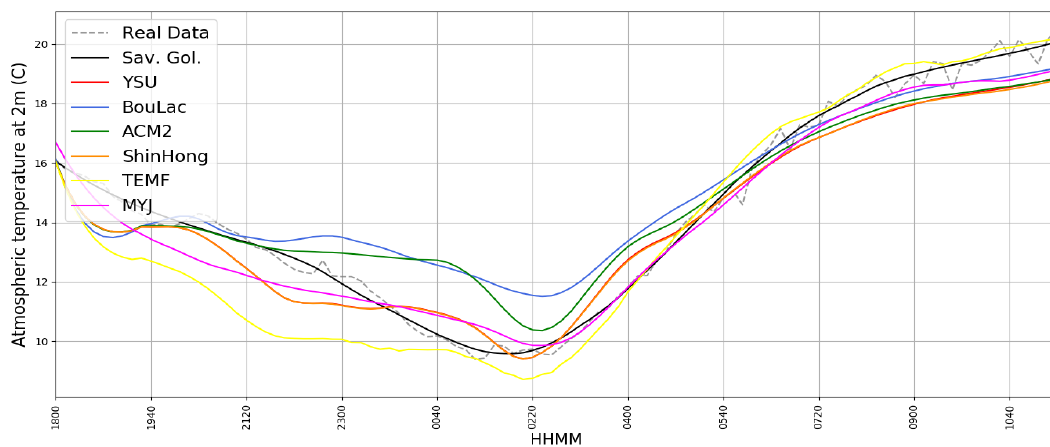
Figure 10 . Simulated T2M timeseries compared with real GL T2M timeseries, 17/05/2017, dotted grey: real data, black: Savitsky – Golay smoothing of real data, red: simulated data with YSU parametrization, blue: simulated data with BouLac parametrization, green: simulated data with ACM2 parametrization, orange: simulated data with ShinHong parametrization, yellow: simulated data with TEMF parametrization, purple: simulated data with MYJ parametrization.